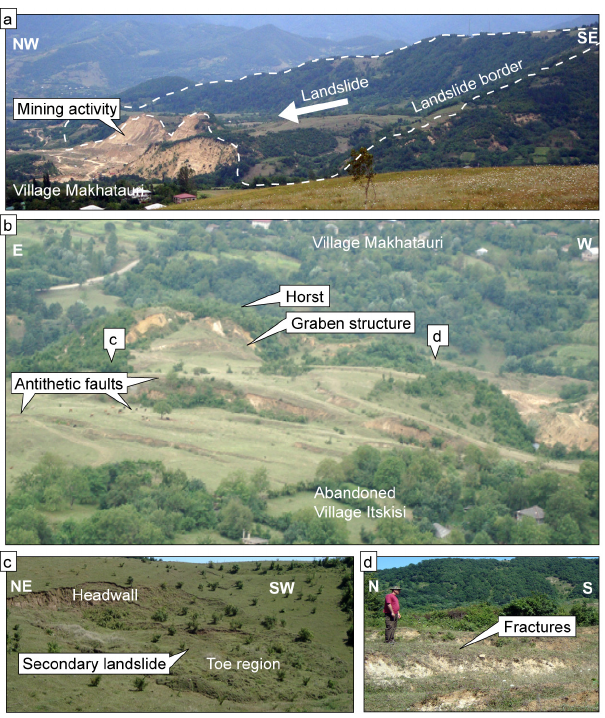
Fig. 6. View of the landslide from the northeast (a) and from the back of the landslide, east–west (b) . There are slopes cut by min- ing activity in image (a) . The white arrow shows the direction of landslide movement. The view of the landslide from the back (b) shows landslide activity structures that are present in the aerial pho- tograph correlated with the InSAR signal in Fig. 5. (c) and (d) show secondary landslides and fractures, respectively. Their positions are shown in image (b) .